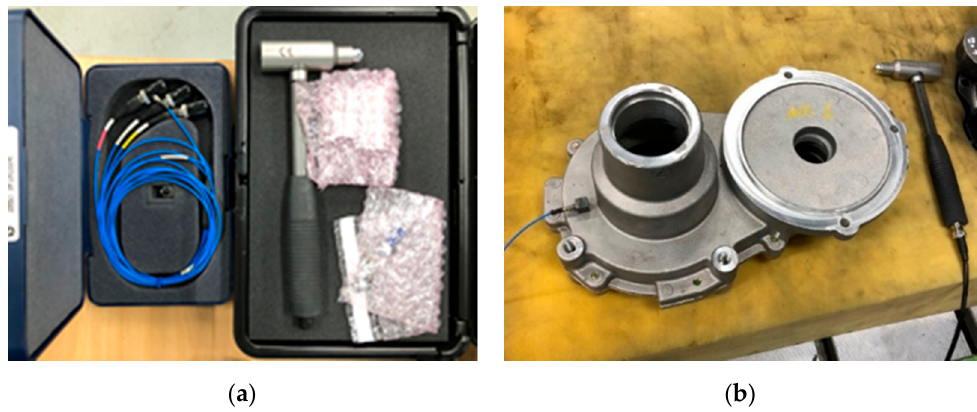
Figure 3. Experimental modal analysis. ( a ) Test equipment; ( b ) Modal testing. Table 1. Specifications of test equipment.